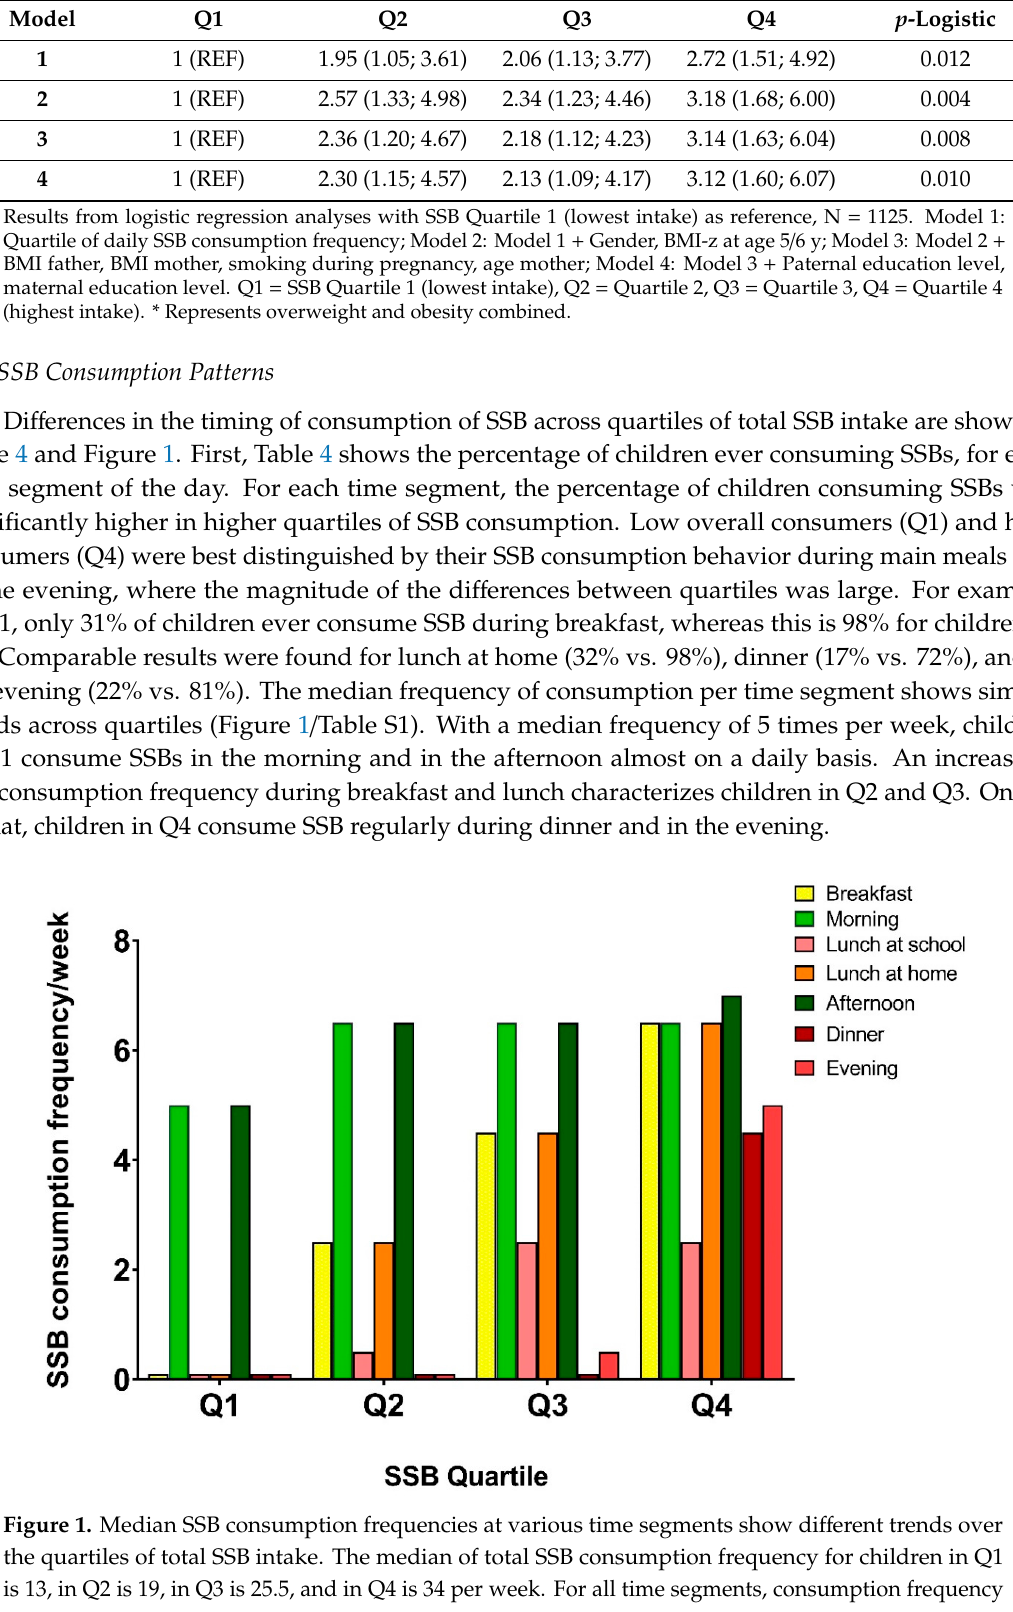
Table 3. Association of SSB consumption frequency quartile at age 5 / 6 years and overweight * incidence in a 5-year period. Presented numbers represented odds ratios (ORs) with 95% confidence intervals.